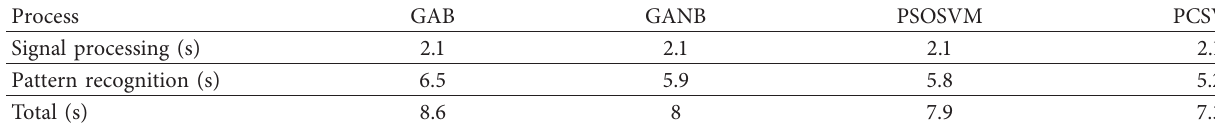
Table 1: Computation complexity of methods.